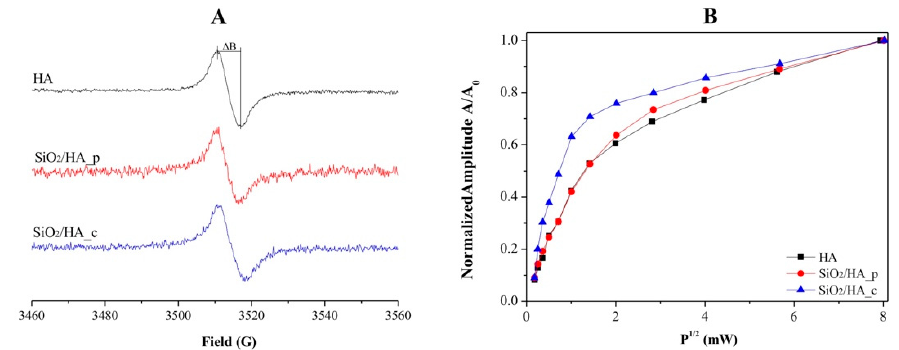
Figure 9. ( A ) EPR spectra and ( B ) power saturation curves obtained by plotting the normalized amplitude (A / A 0 ) values versus the square root of the microwave power intensities (P) of free radicals in HA powder and SiO 2 /HA hybrid nanoparticles. Table 3. Spectral parameters obtained by the EPR spectra of HA and SiO 2 /HA hybrid nanoparticles. Sample